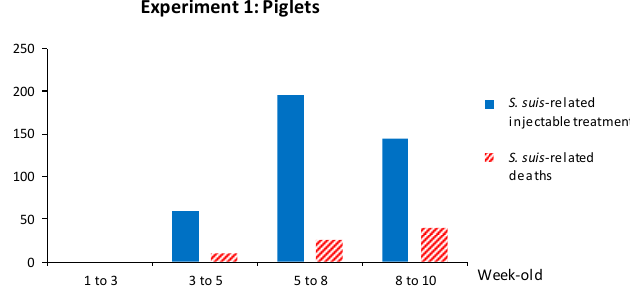
Figure 5. Experiment 1: Number of S. suis -related injectable treatments and S. suis -induced number of deaths in piglets over time. Piglets from non-vaccinated sows were selected ( n = 1494). During the first week, at 4 ± 2 days, each litter was randomly divided into two groups. Group 1 (“vaccinated group”; n = 583) received the autogenous vaccine (as shown in Figure 1) and Group 2 was processed normally (“non-vaccinated group”; n = 911). Piglets were randomly weaned into three nursery rooms, with pigs from Groups 1 and 2 mixed in each pen. S. suis -related mortality and injectable treatments were recorded from all enrolled piglets by farm sta ff daily by room. Pigs were identified as ear notched or not, and there were no individual pig identifiers. As such, an individual pig could be represented more than once in the dataset for treatments. Pigs were followed until the end of the nursery period at approximately 10 weeks of age. In this graph, only S. suis -related mortality and injectable treatments are